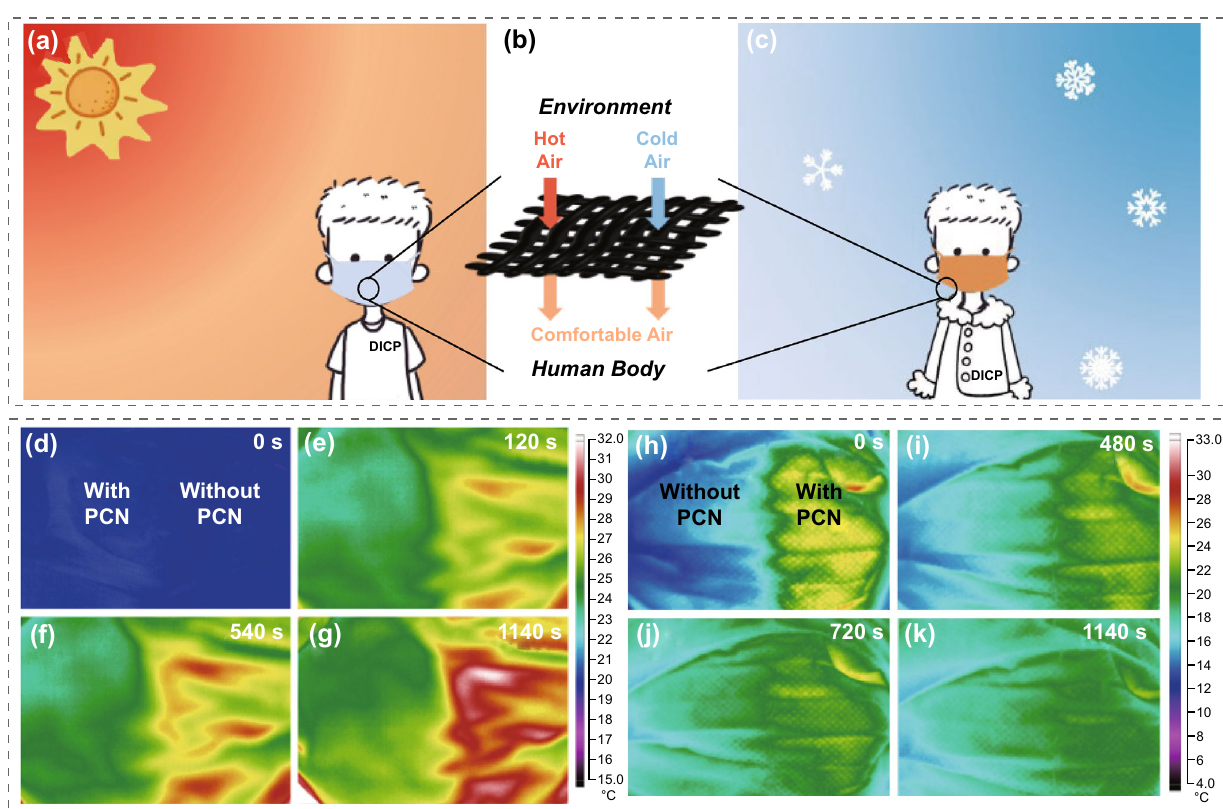
Fig. 5 Wearable thermal management in face masks. a – c Schematic of GB-PCN used for face mask thermal management. The simulative effect through IR images of O-2 GB-PCN for face mask thermal management at different times of d 0 s, e 120 s, f 540 s, g 1140 s under ambient temperature of 38 °C (left part is the functionalized face mask with O-2 GB-PCN, right part is a traditional face mask without O-2 GB-PCN). The actual effect through IR images of E-2 GB-PCN for face mask thermal management at different time of h 0 s, i 480 s, j 720 s, k 1140 s under ambient temperature about 4 °C (right part is the functionalized face mask with E-2 GB-PCN, left part is a traditional face mask without E-2